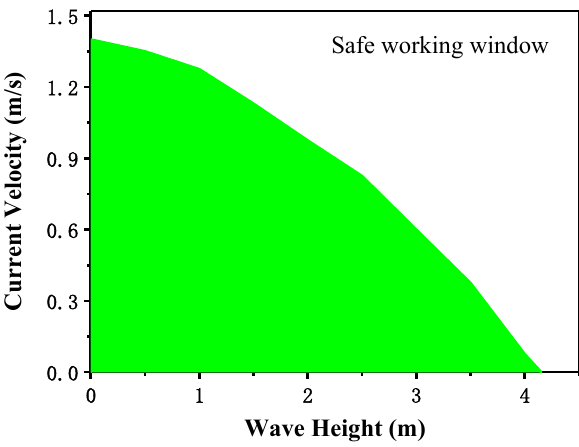
Figure 12. The subsea tree installing safety window.